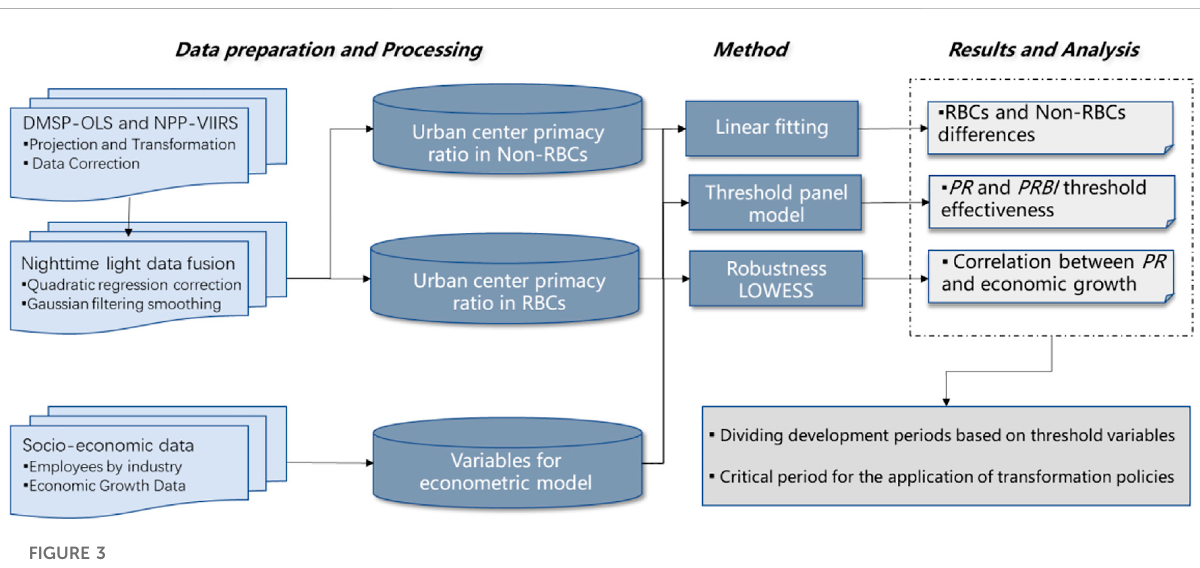
FIGURE 3 Research framework for this